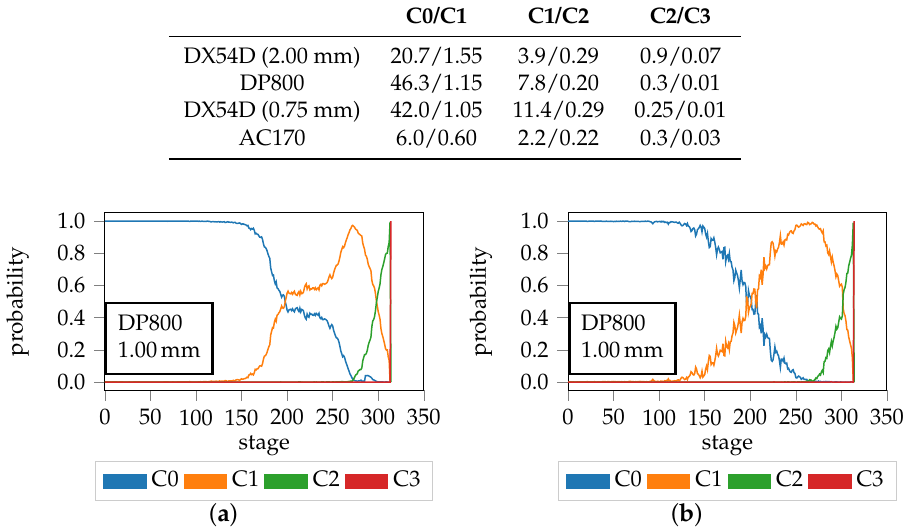
Table 4. Average error per sequence and class (in